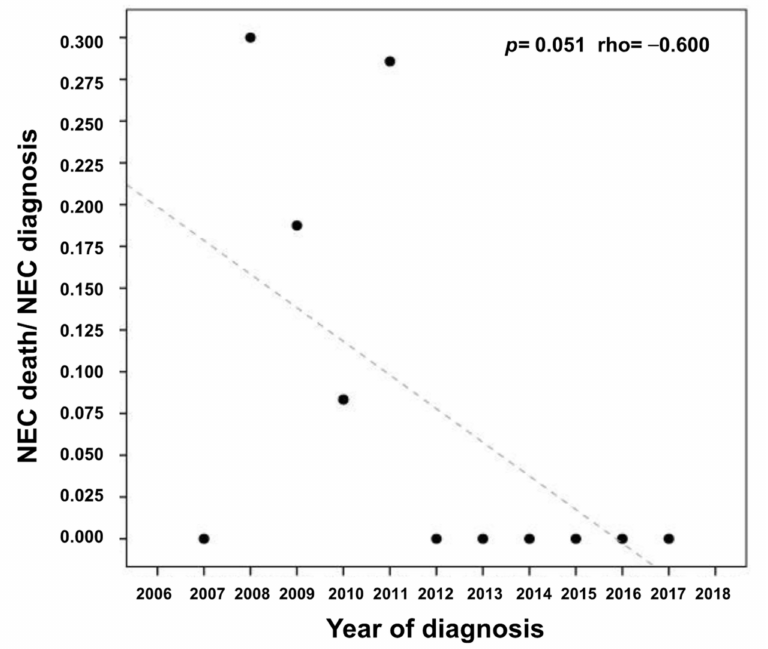
Figure 3. Correlation of mortality rate and incidence of neutropenic enterocolitis per year ( p = 0.051, rho = −